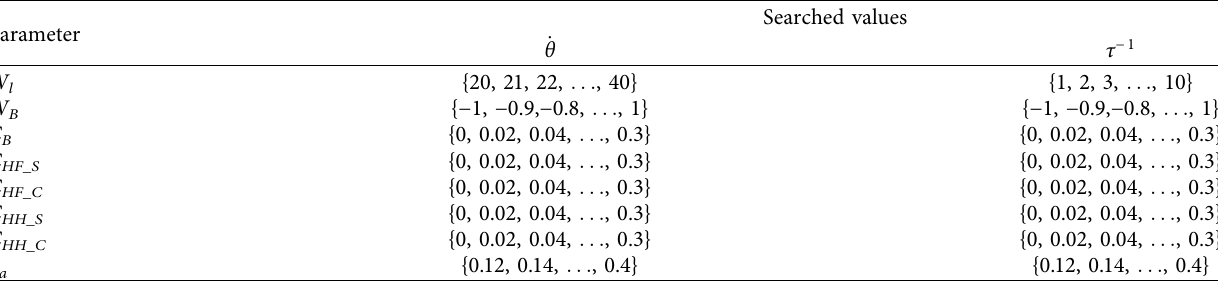
Table 1: Parameter search range.